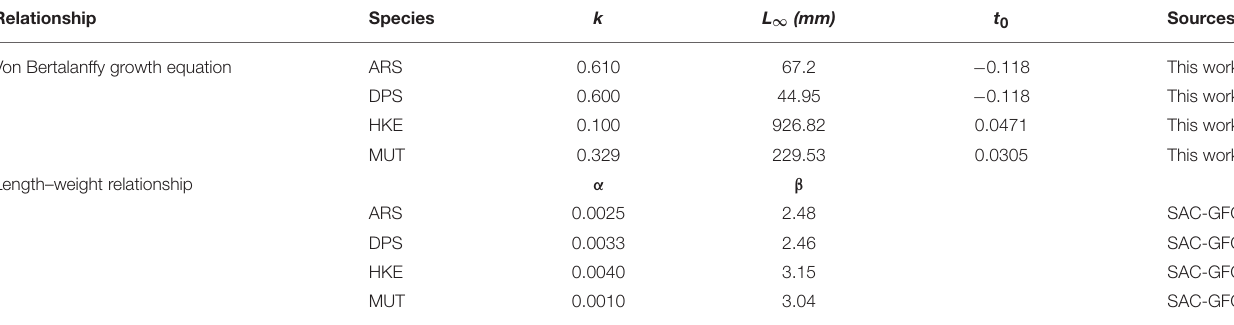
TABLE 1 | Biological parameters not referred to age.